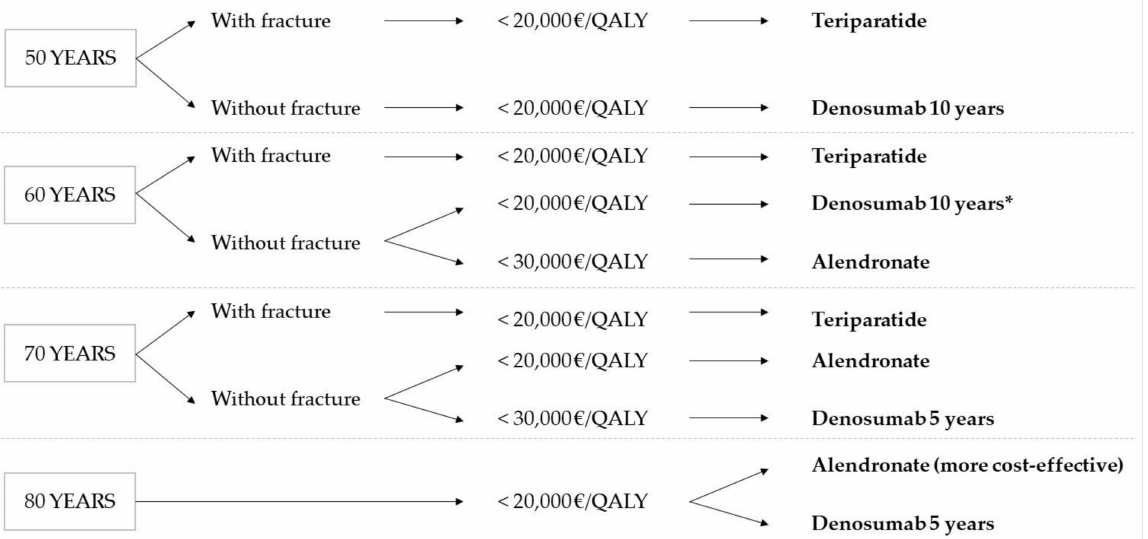
Figure 3. Treatment decision tree according to cost-utility results. * The same result as at 50 is